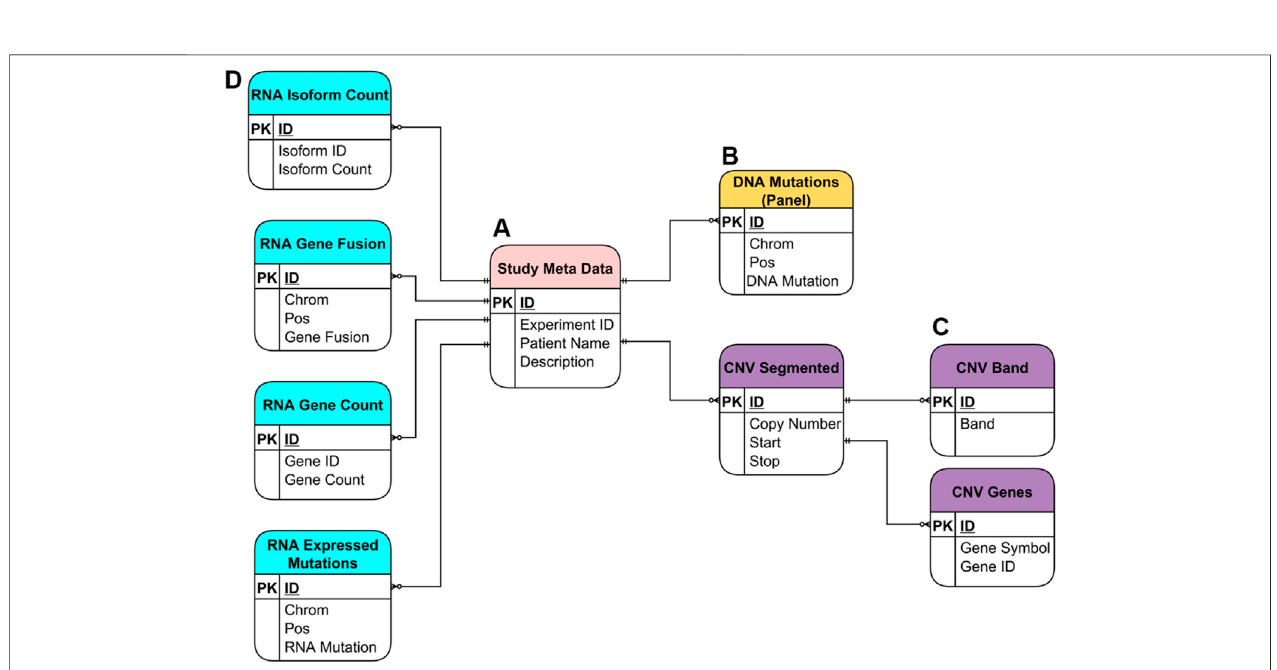
FIGURE 3 | Entity Relationship (ER) Model for the SQLite database utilized in NPARS. Metadata and genomics study data are shown within the context of the databaseschema. (A) Studymetadatatable( “ StudyMetaData ” ),providesacentralrepositoryofmetadata,andmeansofconnectiontotherestofthetables via primary and foreign keys. (B) DNA mutations table [ “ DNA Mutations (Panel) ” ] contains mutational data from a targeted DNA NGS panel. (C) Three tables store copy number variation (CNV) data ( “ CNV Segmented ” ), where each CNV segment is a range of chromosome bases of similar copy number value. Each CNV segment is associated with possibly many genes within it ( “ CNV Genes ” ), and with possibly many cytobands ( “ CNV Band ” ). (D) The four tables which hold RNA-based study data: isoform count ( “ RNA Isoform Count ” ), gene fusions ( “ RNA Gene Fusion ” ), gene count ( “ RNA Gene Count ” ) and, expressed mutations ( “ RNA Expressed Mutations ” ).